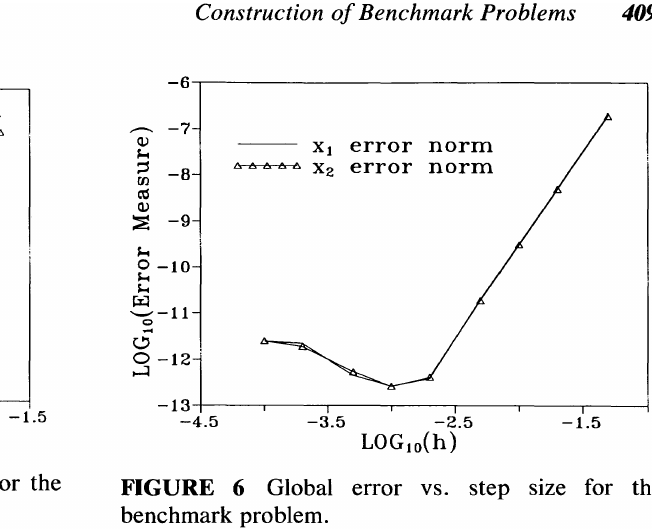
FIGURE 6 Global error vs. step size for the benchmark problem.